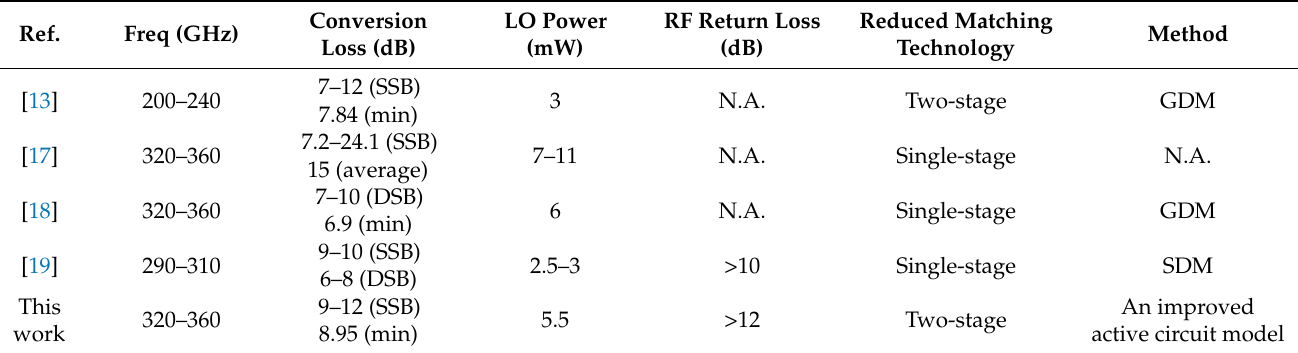
Figure 10. The experimental results of a 0.34 THz sub-harmonic mixer combining two-stage reduced matching technology with an improved active circuit model. ( a ) IF frequency ( f IF = f RF − 2 f LO ): 1 GHz and 2 GHz; ( b ) IF frequency ( f IF = 2 f LO − f RF ): 1 GHz and 2 GHz; ( c ) LO frequency: 163 GHz and 165 GHz; ( d ) LO frequency: 170 GHz and 172 GHz; ( e ) The simulated and measured RF return loss when the LO frequency is fixed at 165 GHz; ( f ) The comparison of SSB conversion loss. Table 1. Summary of some published sub-harmonic